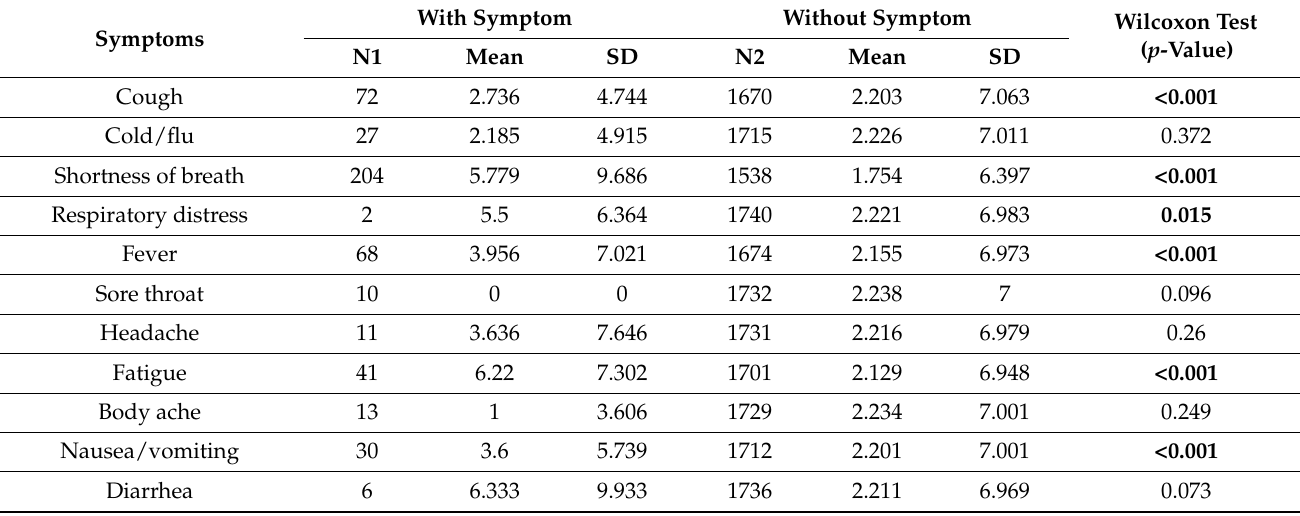
Table 3. Length of hospital stay (in days) in the first visit.